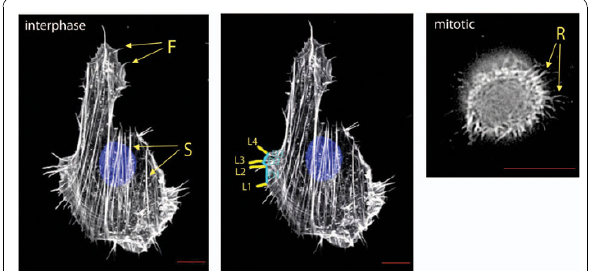
Figure 1 The actin cytoskeleton in Rat2 cells . Rat2 fibroblast cell stained for actin (white) and DNA (blue). The leftmost panel shows transverse actin stress fibers (S) and filopodia (F) as hair-like projections from the cell perimeter. The central panel shows counting of individual filopodia lengths (L1, L2, L3, L4) and distance separation (D1, D2, D3). The right panel shows a mitotic cell with retraction fibers (R) indicated. The red scale bar is 10 μ